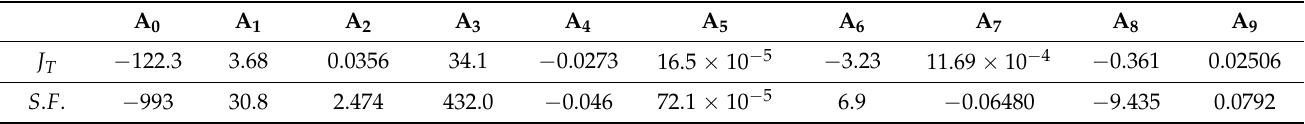
Table 2. The coefficients in Equations (4) and